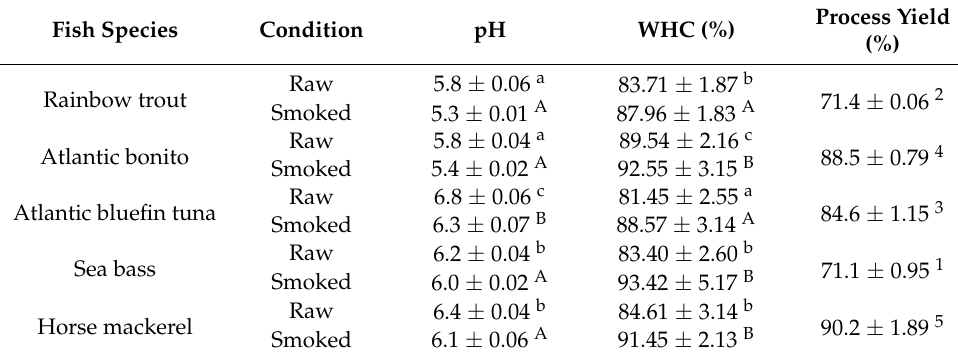
Table 2. pH, WHC and yield of fresh and smoked fish